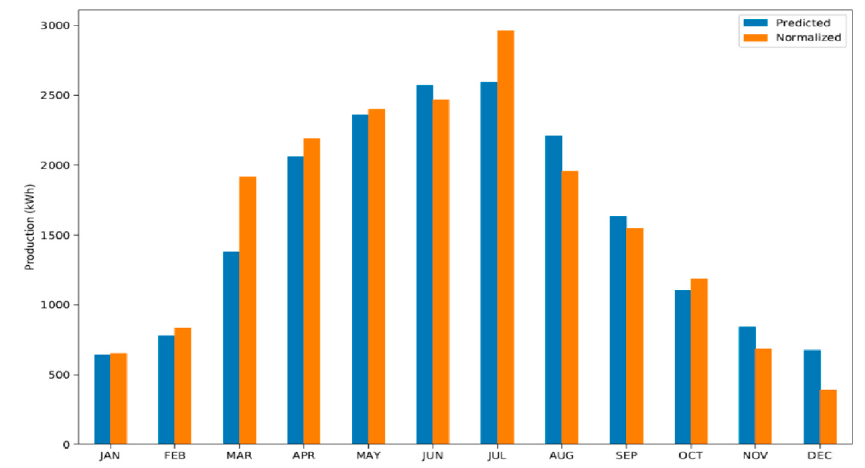
Figure 2. Comparison of predicted and normalised values of monthly solar production.